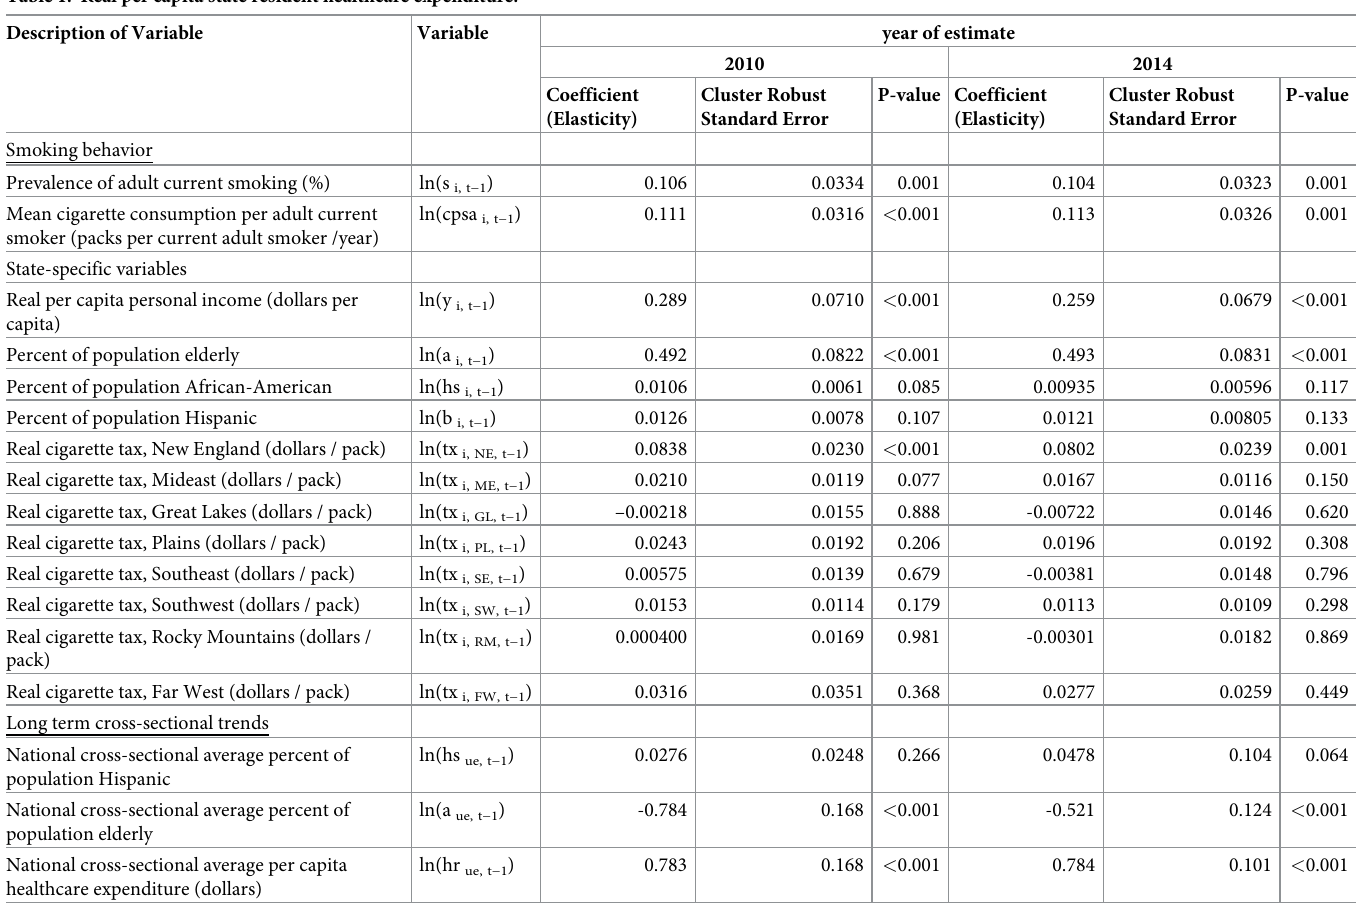
Table 1. Real per capita state resident healthcare